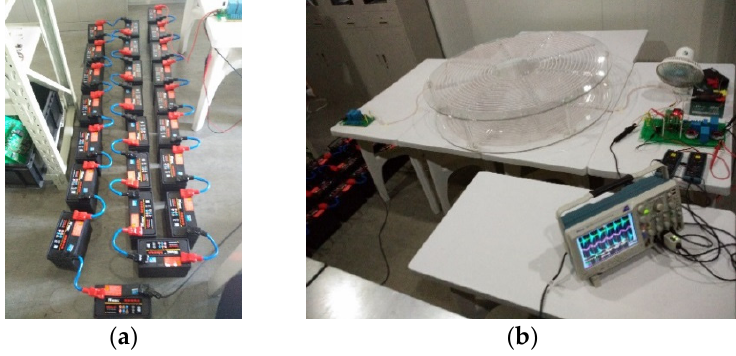
Figure 12. Prototype of wireless power transfer system. ( a ) 300V lead ‐ acid battery pack. ( b ) Transmitter and receiver of wireless power transfer system. The magnetic coil is placed on the top of a perspex plate and fixed by eight perspex bars.